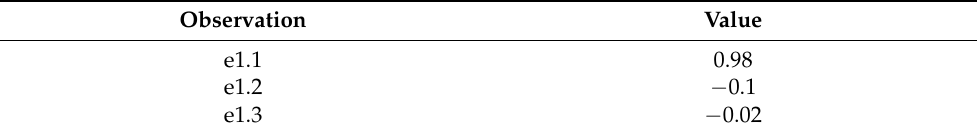
Table 1. Assignment of particular values for h1. Prepared by the authors on the basis of [2,3,53,54].